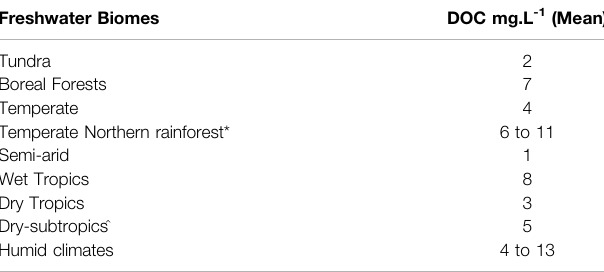
Frontiers in Environmental Science |